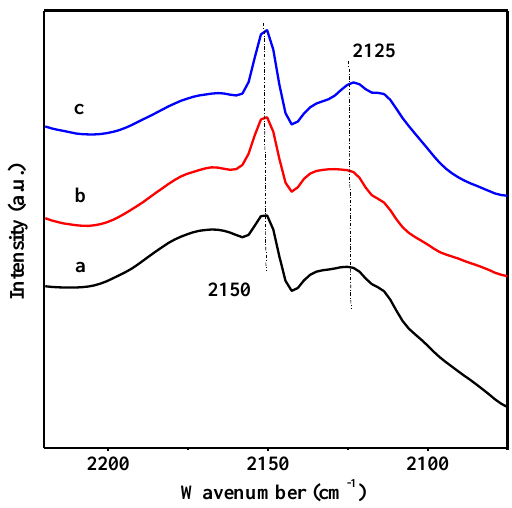
Figure 7. FTIR spectra of various samples recorded after outgassing at 473 K for two hours, after adsorption of CO at room temperature. (a) UiO-66; (b) 40 wt % WO 3 /UiO-66; (c) 15 wt % B 2 O 3 -40 wt % WO 3 /UiO-66.